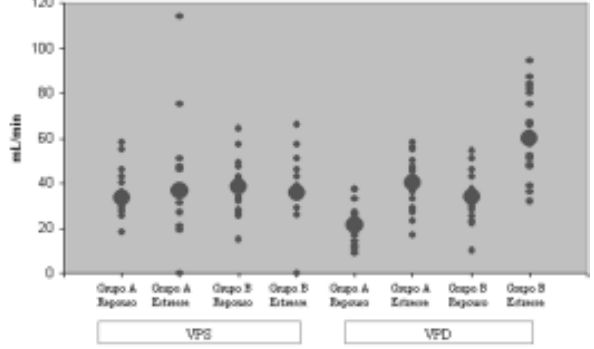
Fig. 6 - Dispersão dos valores das velocidades de pico sistólico (VPS) e diastólico (VPD), em cm/s, nos grupos A e B, em repouso e em estresse. As médias dos valores do VPS e VPD foram